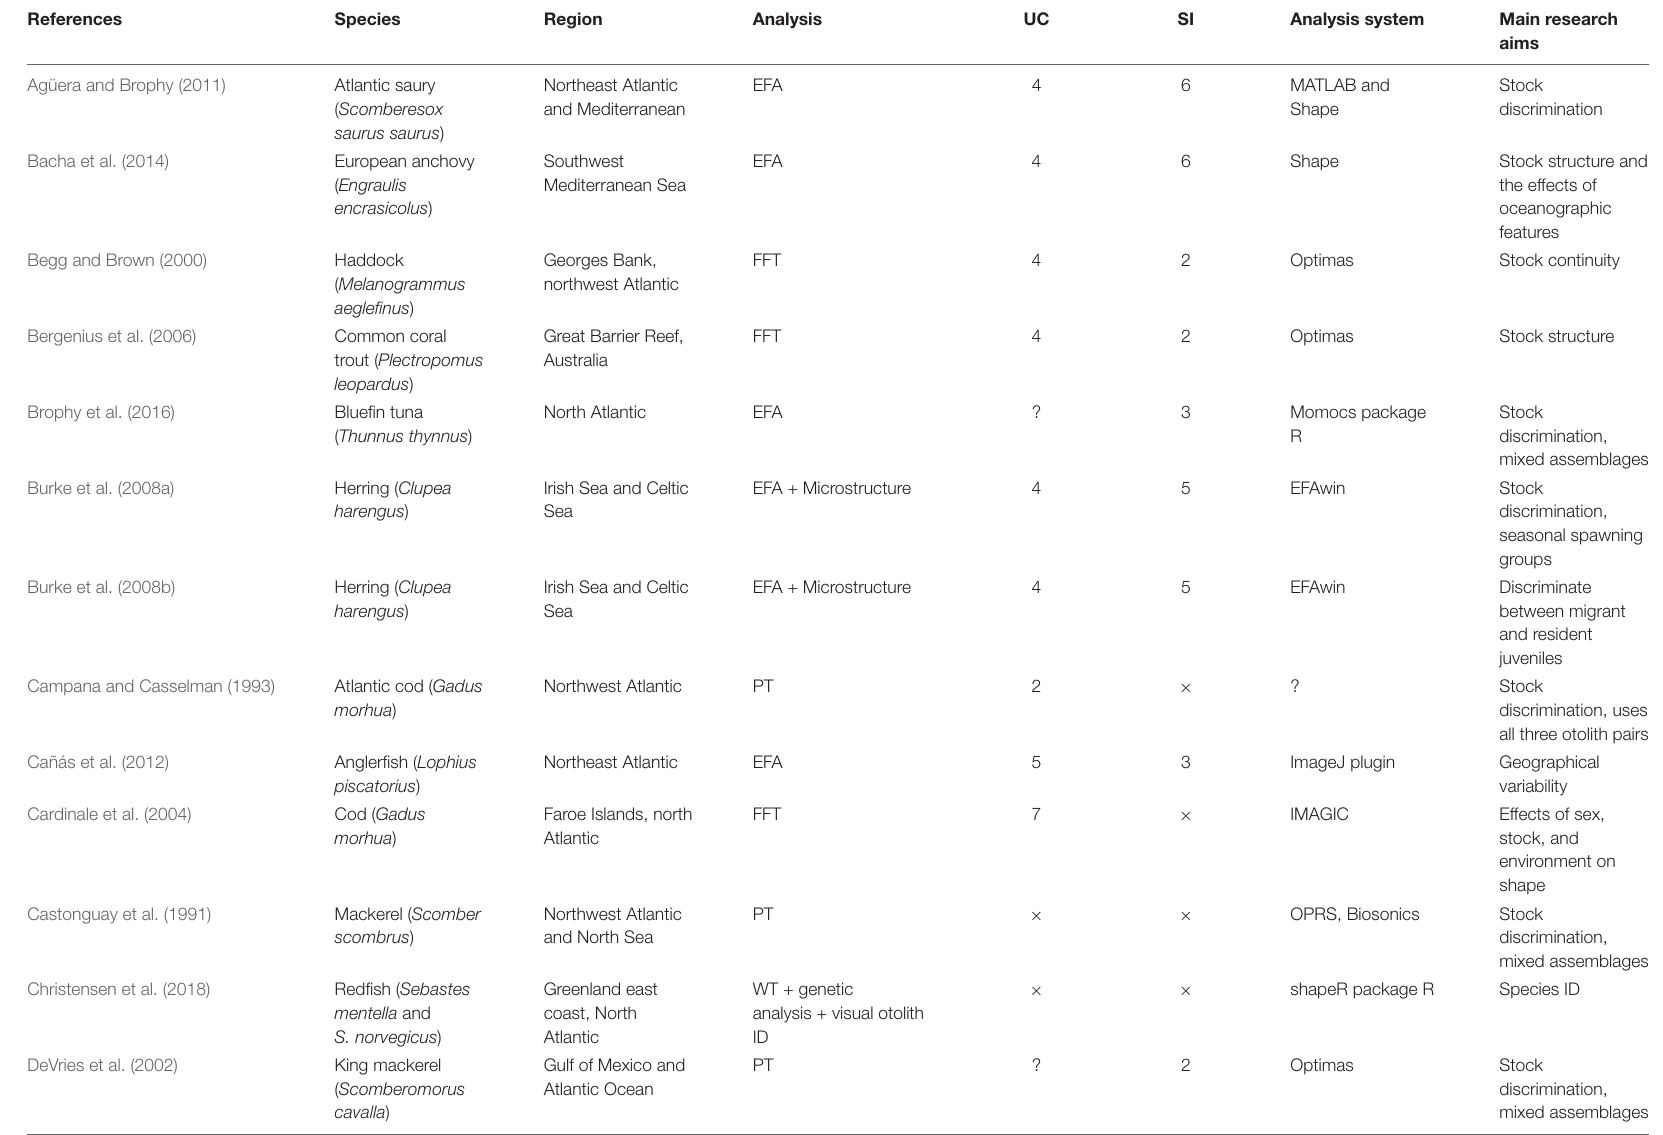
TABLE 2 | Summary of otolith outline studies with analysis undertaken using: elliptic Fourier analysis (EFA), fast Fourier transform (FFT), polar transform (PT), or Wavelet transform